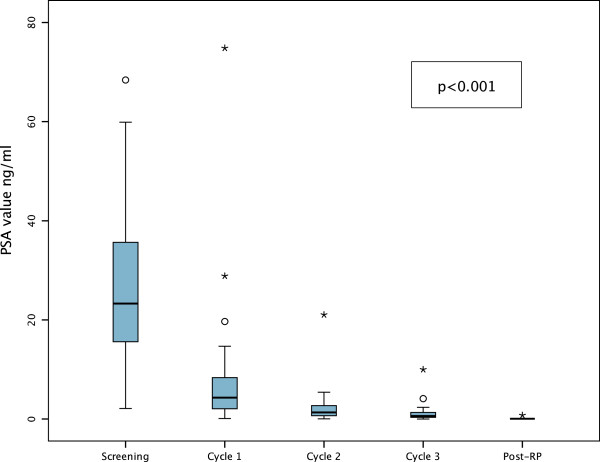
Boxplot diagram showing prostate specific antigen (PSA)-response by treatment interval in the complete cohort of patients; extreme values (n = 3) at screening are not presented for graphing reasons; Abbreviations:
o
, outliers; *, extreme outliers; RP, radical prostatectomy.